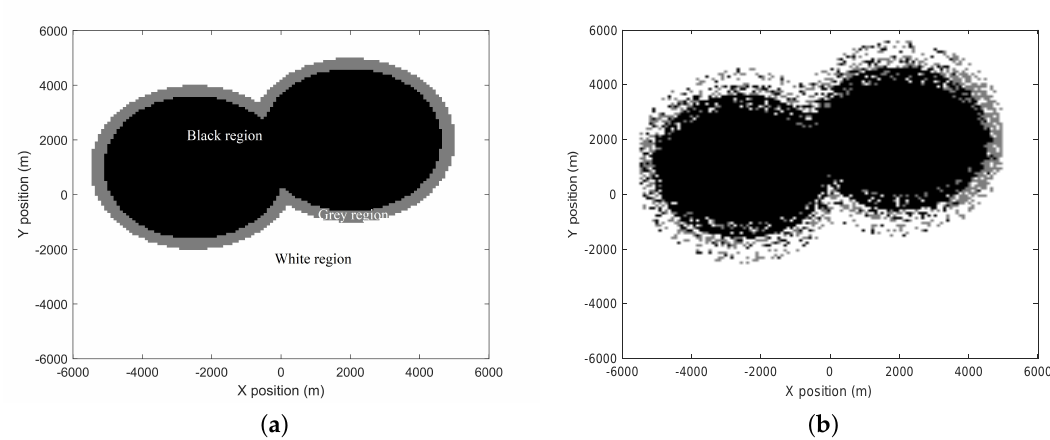
Figure 6. Region division when there are two active PUTs in the CCRN. ( a ) Regions ideally identified when there are two active PUTs in the CCRN. ( b ) Regions predicted when there are two active PUTs in the CCRN ( E P = 5 W).